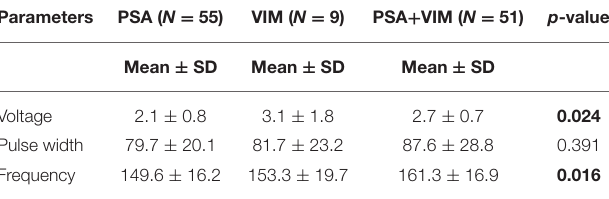
TABLE 4 | Chronic stimulation